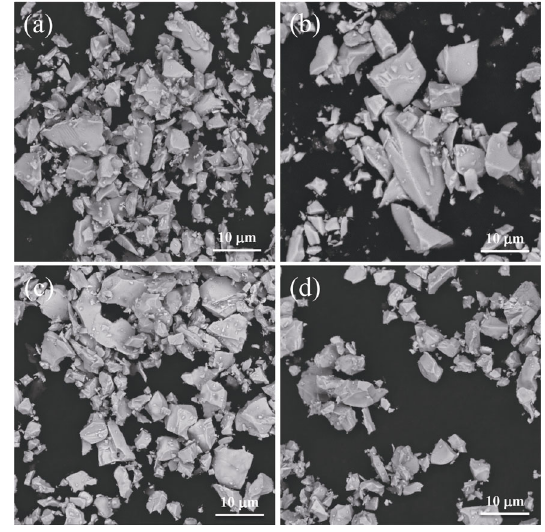
SEM images of multi-component carbide powders after sintering: (a) Zr 0.5 Hf 0.25 Ti 0.25 C 0.7 , (b) Zr 0.375 Hf 0.375 Ti 0.25 C 0.7 , (c) Zr 1/3 Hf 1/3 Ti 1/3 C 0.8 , and (d) Zr